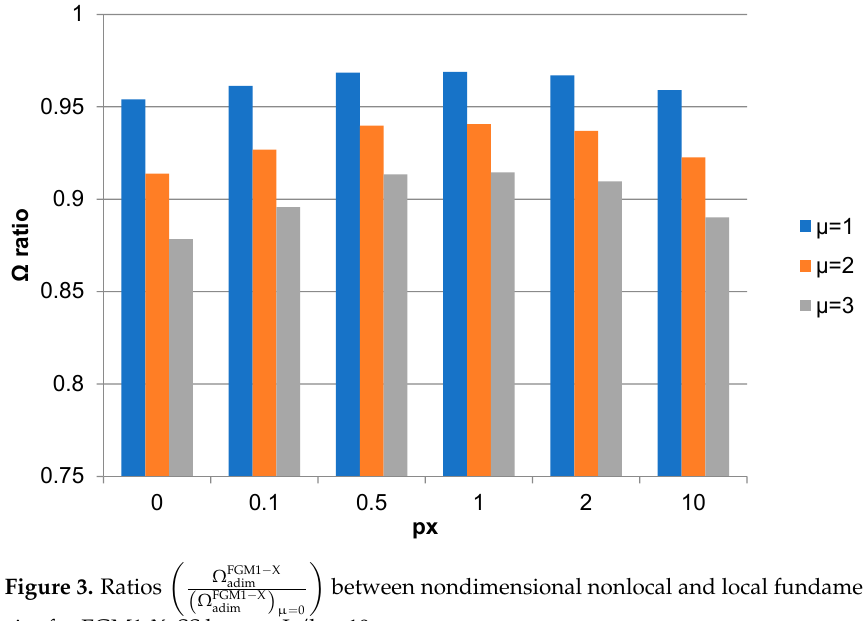
(cid:18) (cid:19) Ω FGM1 − X (cid:3159)(cid:3162)(cid:3167)(cid:3171)(cid:3138)(cid:3139)(cid:3145)(cid:3117)(cid:3127)(cid:3156) Figure 3. Ratios between nondimensional nonlocal and local fundamental frequen- (cid:4679) between nondimensional nonlocal and local fundamental frequen- adim Figure 3. Ratios (cid:4678) (cid:2960) ( Ω FGM1 − X ) (cid:3435)(cid:2960) (cid:3159)(cid:3162)(cid:3167)(cid:3171)(cid:3138)(cid:3139)(cid:3145)(cid:3117)(cid:3127)(cid:3156) (cid:3439) adim µ = 0 (cid:3220)(cid:3128)(cid:3116) cies for FGM1-X, SS beams. L/h = cies for FGM1-X, SS beams. L/h = 10.